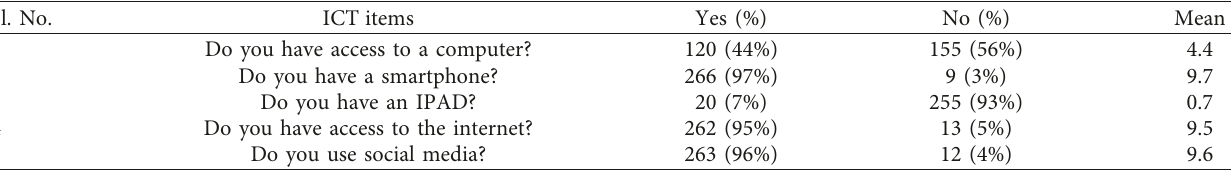
Table 4: Allocation, frequency, and mean on the access to ICT tools.